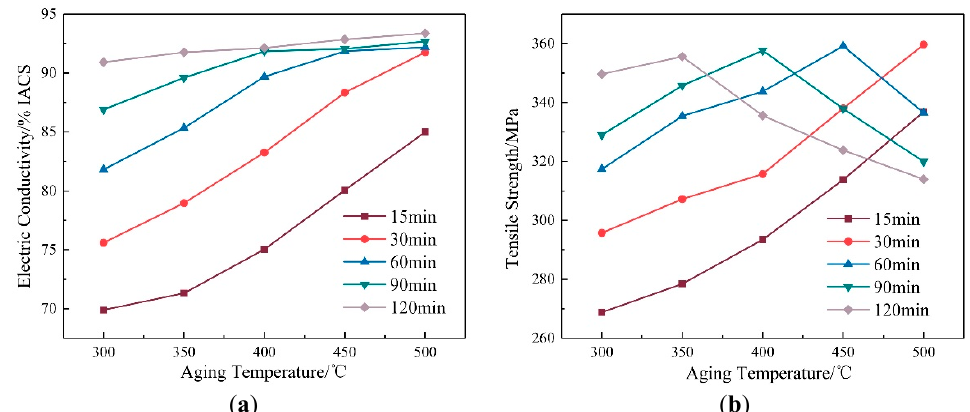
Figure 3. Property curves of the alloy with ageing temperature: ( a ) Electric conductivity; ( b ) tensile strength.